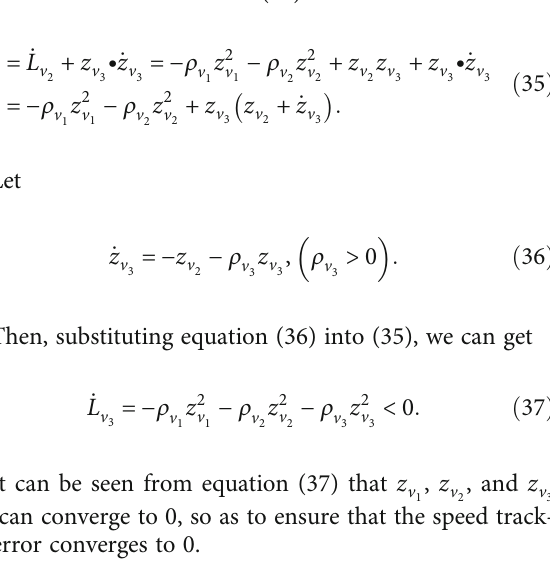
Figure 2: Block diagram of the DSC Table 2: The parameters and uncertainty boundary of NSV.